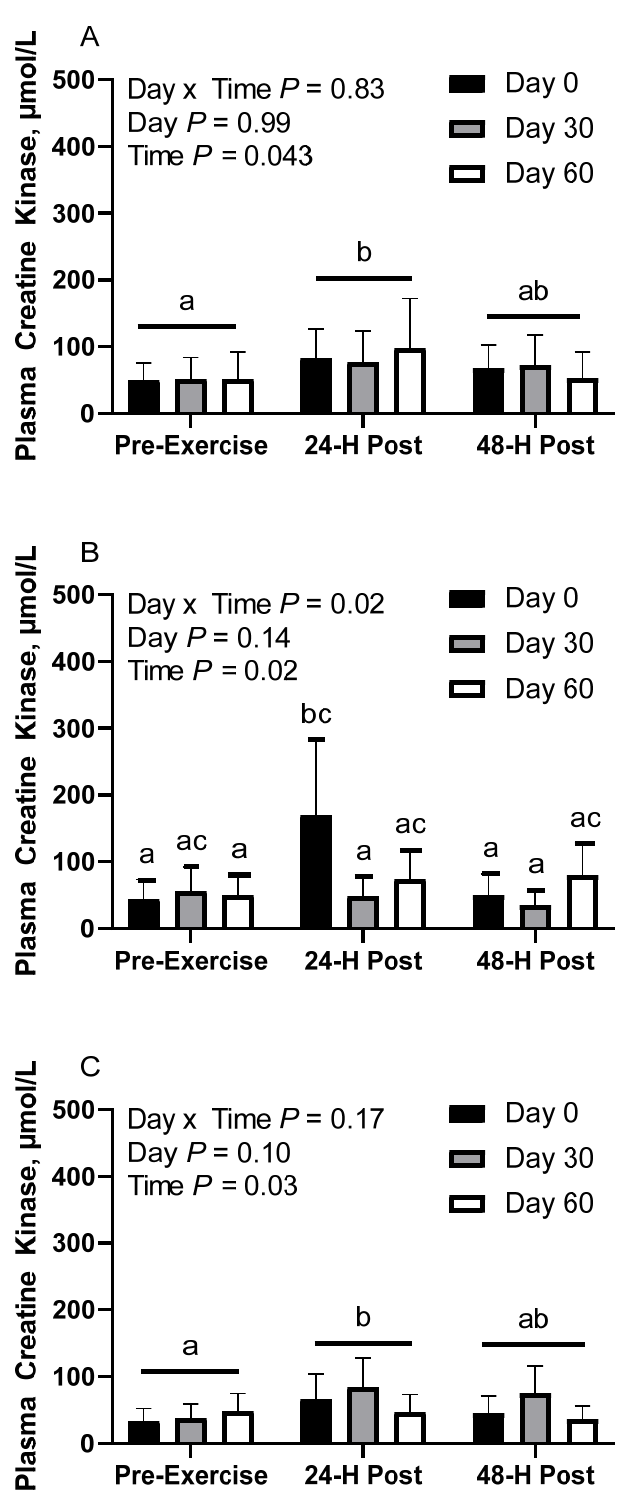
Figure 5. Geometric mean [LCI, UCI] fasting, 30 min post-exercise, and 24 h post-exercise plasma creatine kinase activity in young horses fed 60% energy from hay (coastal bermudagrass) and 40% energy from concentrate (SafeChoice Original, Cargill Animal Nutrition, St. Paul, MN, USA) on d 0, 30, and 60 of a 60-day feeding trial. Where CON ( A ) did not receive dietary alteration, FLAX ( B ) had 25% of concentrate calories replaced with a flaxseed oil blend, and RICE ( C ) had 25% of concentrate calories replaced with crude rice bran oil. a,b,c Means not sharing a superscript differ p <